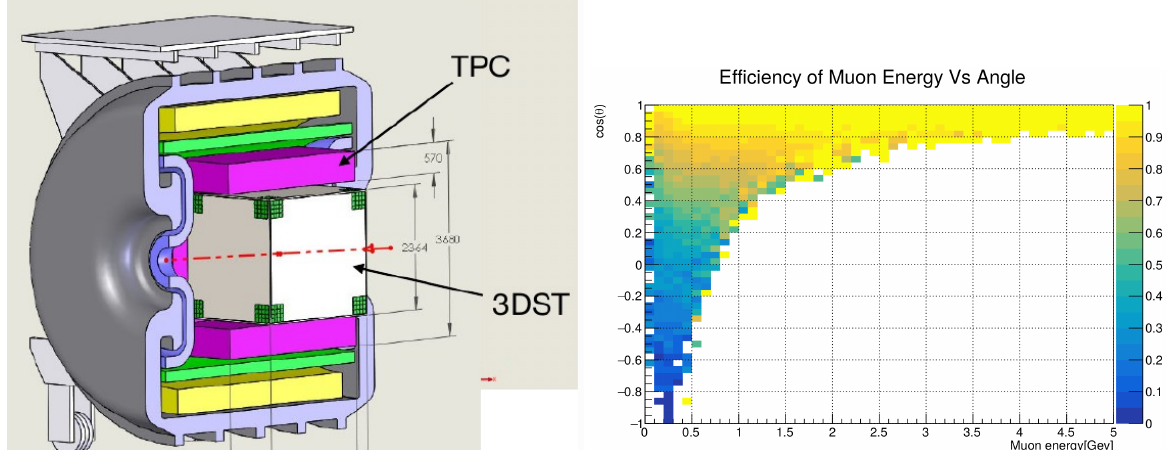
Figure 129. ( Left ): A cutaway view of the SAND reference design with the 3DST and the three surrounding TPCs . ( Right ): The efficiency to reconstruct muons generated by neutrino interactions in the 3DST that escape and enter into the TPCs. Note, the acceptance is low for backward going muons but it is not zero since tracks can be bent into the TPCs by curvature in the magnetic